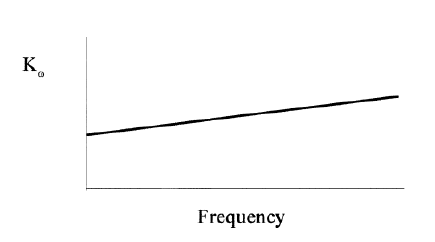
Fig. 2. Dynamic stiffness of rubber engine mount